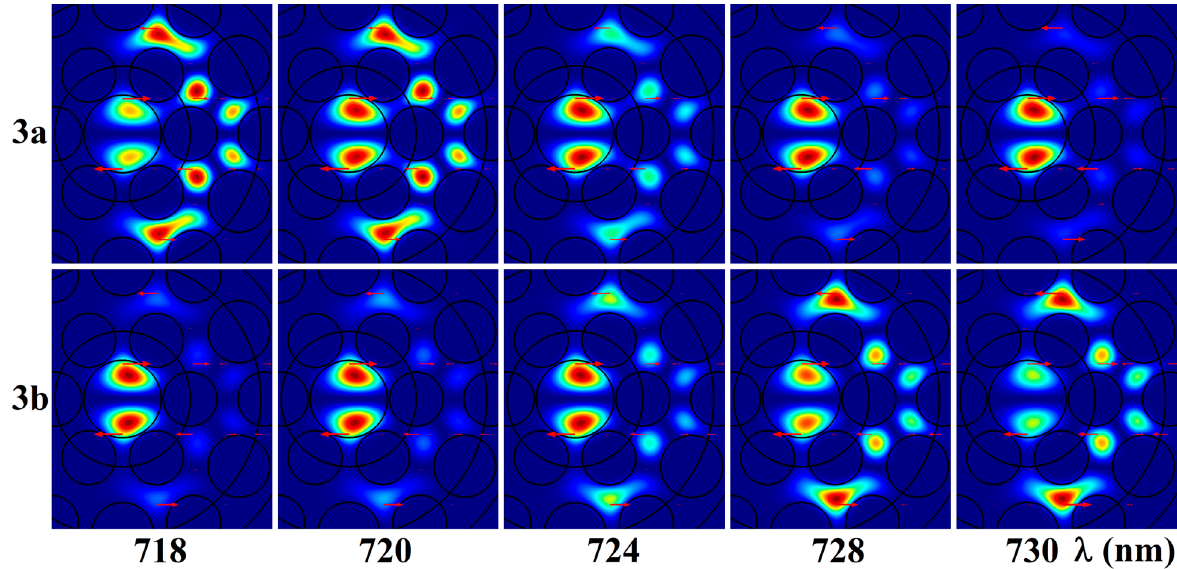
Figure 11. Spatial intensity distributions of Modes 3a and 3b in the bent MOF-18 for a bending radius of R x = 0.08 m for wavelengths of 718 nm, 720 nm, 724 nm, 728 nm, and 730 nm. The spectral dependences of leakage losses ( α 3a and α 3b ) and intensities ( I 3a and I 3b ) of Modes 3a and 3b in bent MOF-18 for a bending radius of R x = 0.08 m have characters that